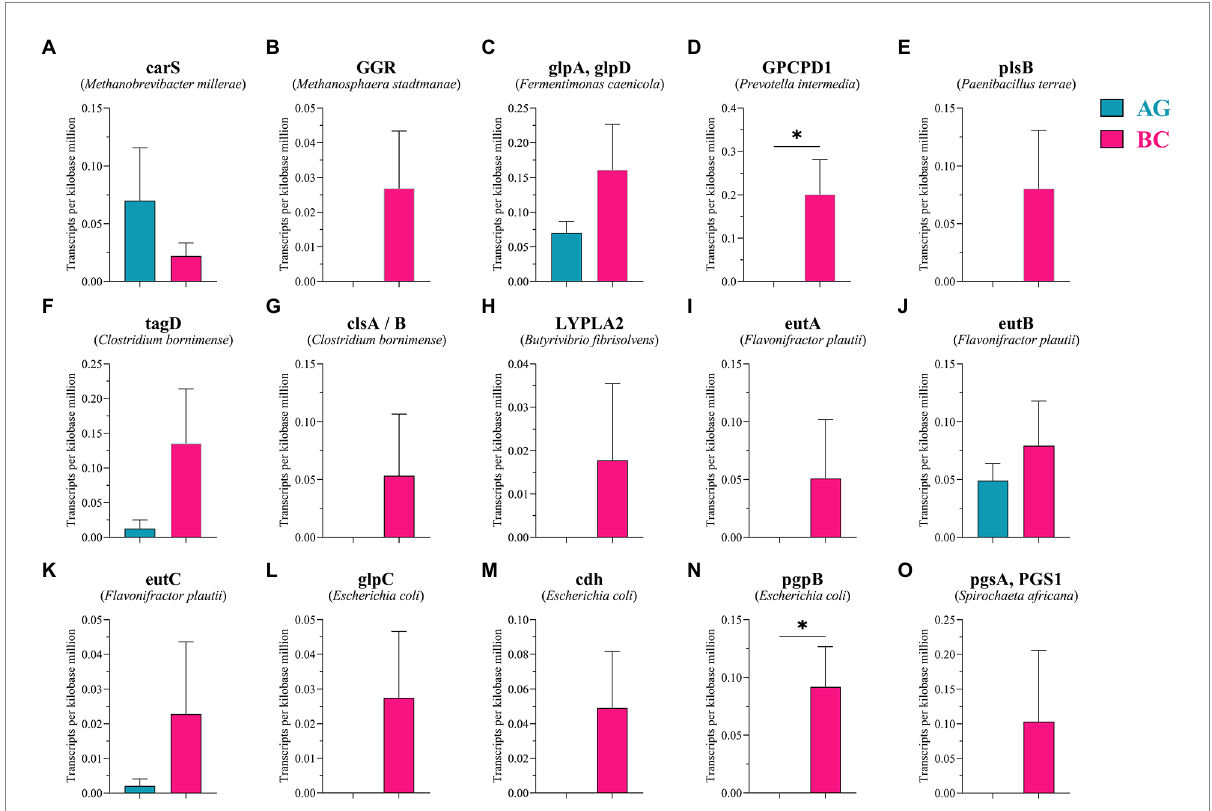
FIGURE 8 The relative abundance of genes related to lipid metabolism in lipid metabolism pathways between Xinjiang brown cattle (BC) and Angus cattle (AG). ( n = 5 in each breed). The expression of genes related to lipid metabolism (A–O) . Values were expressed as means ± SEM. * denotes p < 0.05 indicating significant difference.